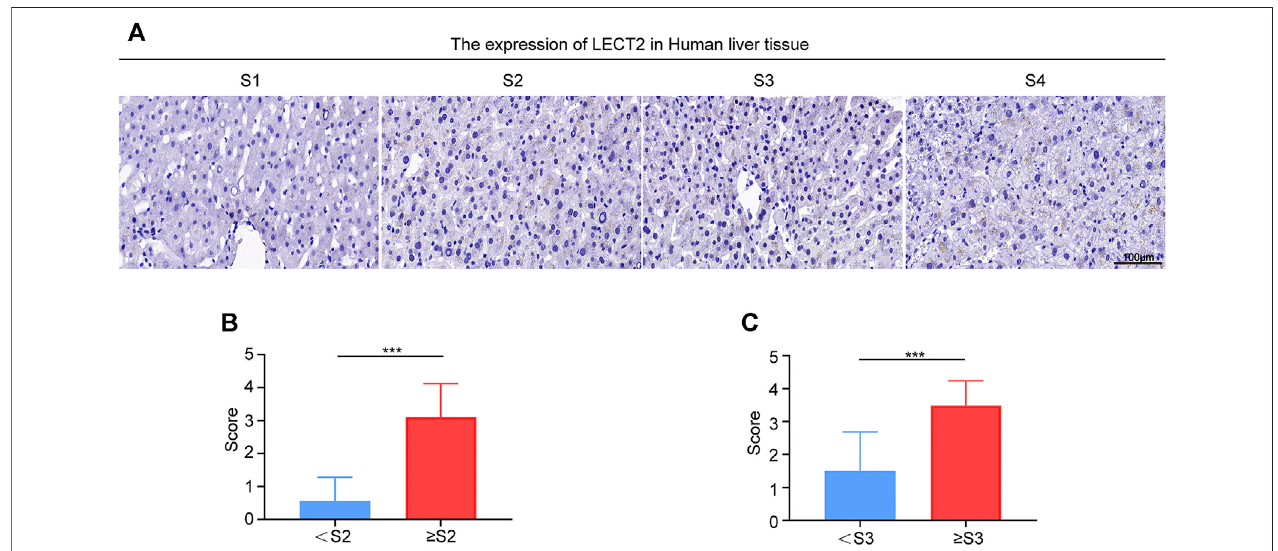
FIGURE 5 | Expression of LECT2 mRNA in the human liver tissue. (A) Representative photomicrographs of RNAscope in situ hybridization (ISH) showing LECT2 expression in liver tissues sections from CHB patients in different stages of liver fi brosis. (B) and (C) show the quantitative analysis of the results of RNAscope in situ hybridization (ISH) in (A) . *** p <